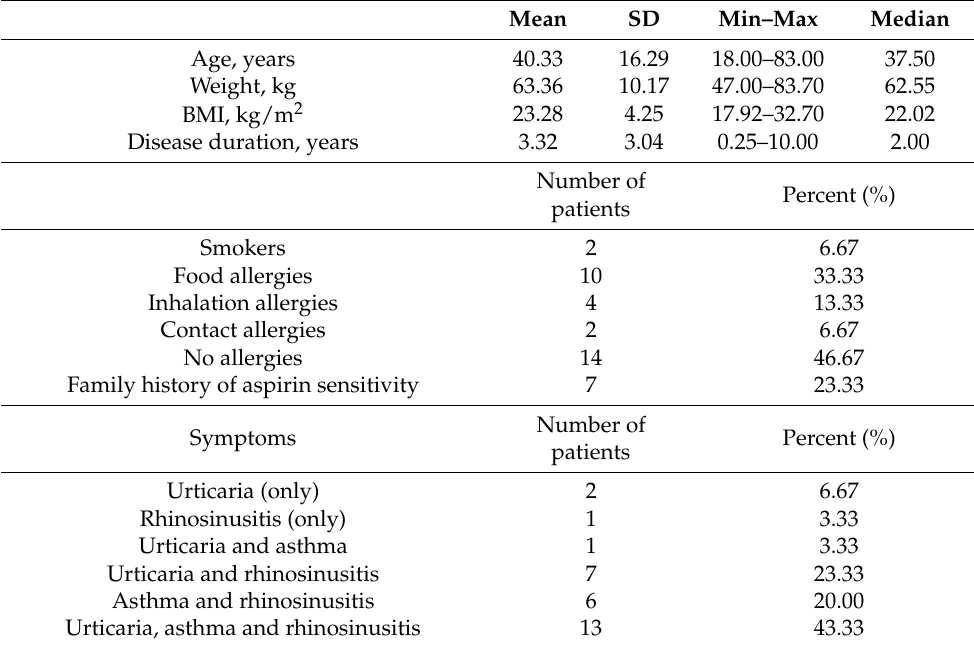
Table 1. Baseline characteristics of the study group, n = 30.